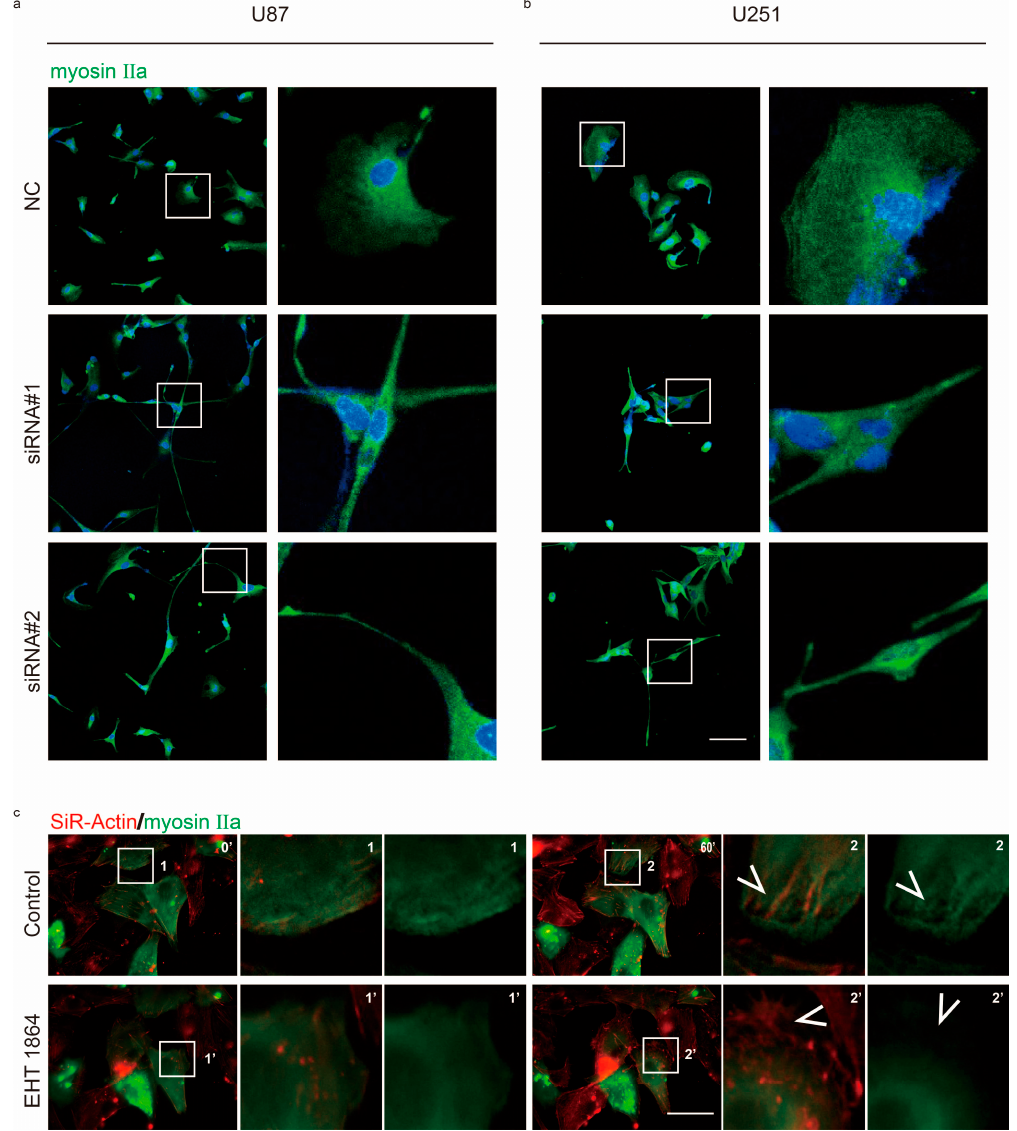
Figure 3. Rac1 regulates myosin IIa localization. ( a,b ) Confocal sections of U87 and U251 cells depleted of Rac1 48 h post-transfection and stained for myosin IIa (green). ( c ) Time-lapse images of SiR-actin staining and myosin IIa-GFP-expressing U87 cells. After 60 min, 10 µ m EHT 1864 was added and recorded for another 60 min. Arrows indicate actin fibers and myosin IIa localization in the protrusion. Recordings are shown in Videos S6 and S7. Scale bar: 50 µ